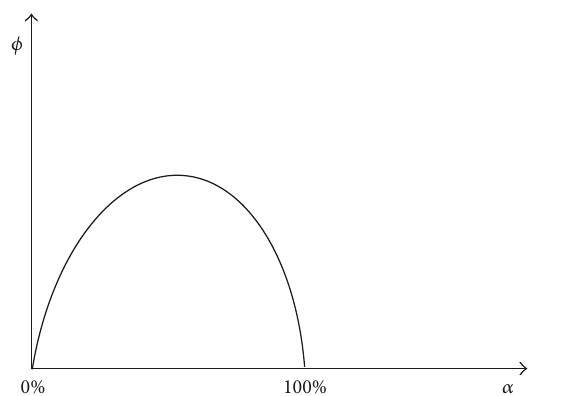
Figure 1: Relationship between thepriceof anarchy (𝜙) and the level of congestion (𝛼) in a road network.